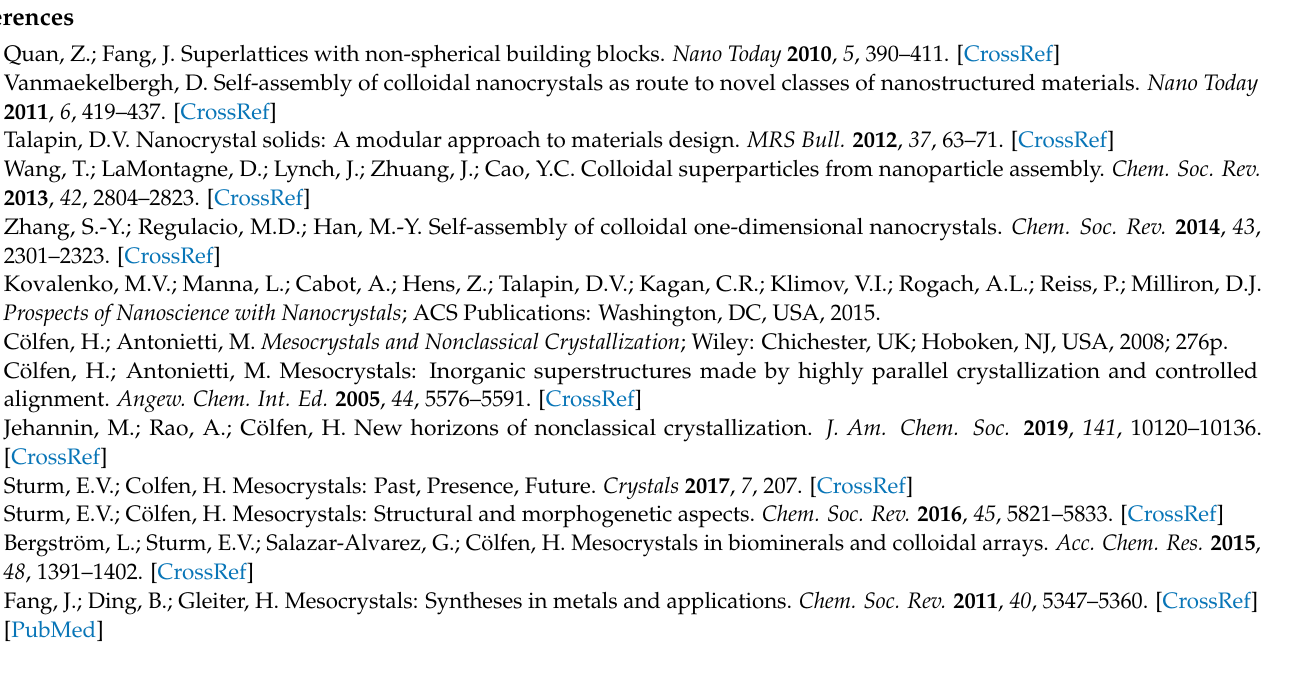
Figure S2: Platinum mesocrystals on quartz surfaces, Figure S3: Elemental analysis of platinum mesocrystals, Figure S4: Small-angle X-ray scattering of platinum mesocrystals, Figure S5: Polycrys- talline platinum